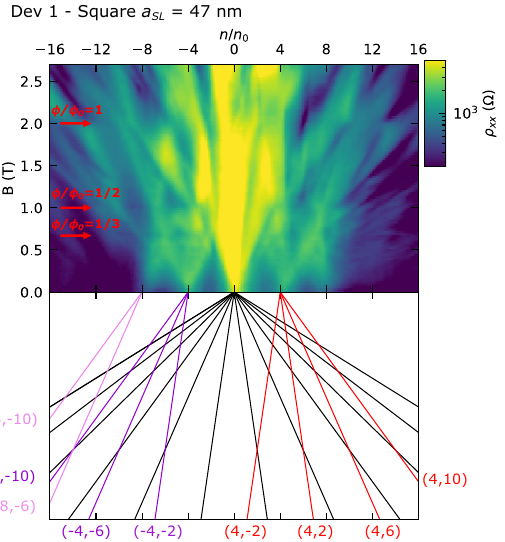
Dev 2 ( V PBG =1 : 4 V), Landau fans emerge from n = n 0 =0,±4. These are solid evi- denceoftheformationofan18nmperiodsuperlattice(SL).Coloredlinesbelowthe magneto-resistancemapsindicatetheobservedLandaufans.LabelsindicatetheSL LL Þ fi lling fraction and Landau level ð n = n 0 ,